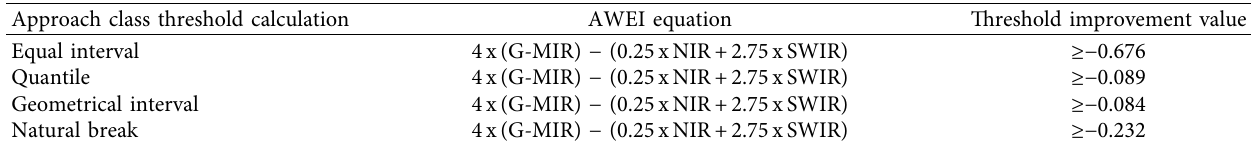
Table 2: AWEI threshold improvements are based on the mean value calculation of the local threshold of the second-stage split scene image selection for surface water